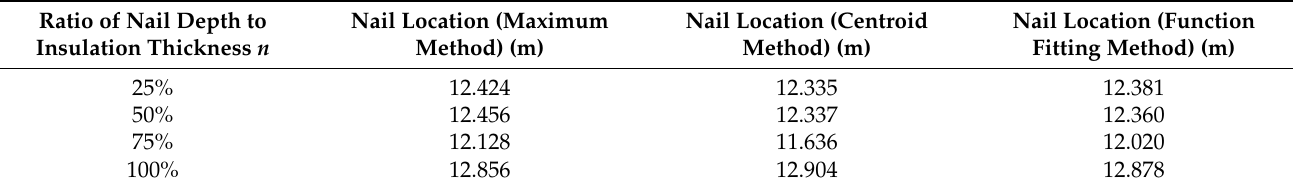
Table 2. The nail locating results of different inserted depths.